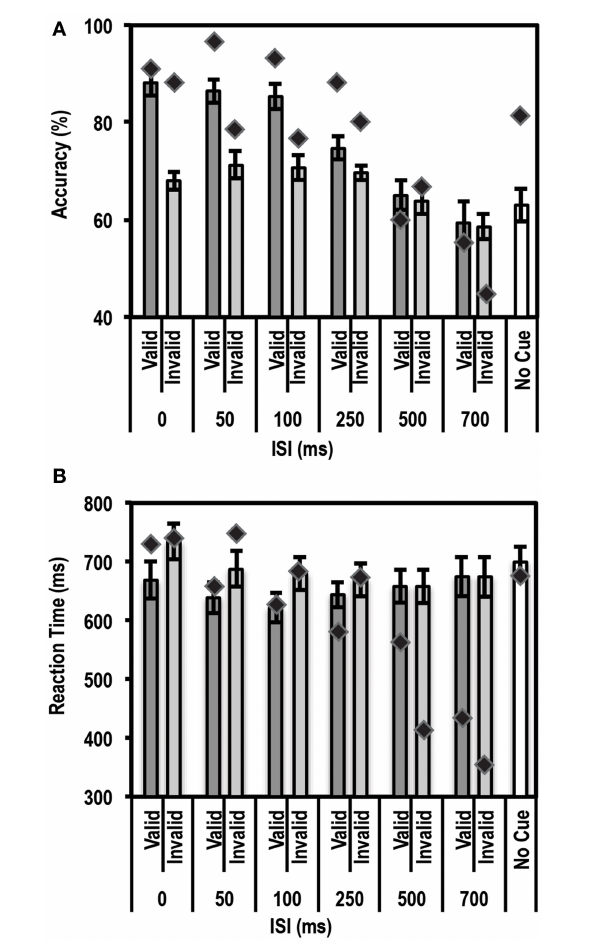
FIGURE 4 | Average accuracy (A) and Reaction Time (RT) data (B) for age-matched controls ( N = 10) and the patient for the Exogenous Cueing Task. Dark gray bars represent performance on validly cued trials. Light gray bars represent performance on invalidly cue trials. Unshaded bars show performance on No-Cue trials. Error bars represent standard error of the mean for the control group. Diamond markers indicate performance of the patient. The patient showed similar facilitation effects as the control group for short ISI but not for long ISI trials.